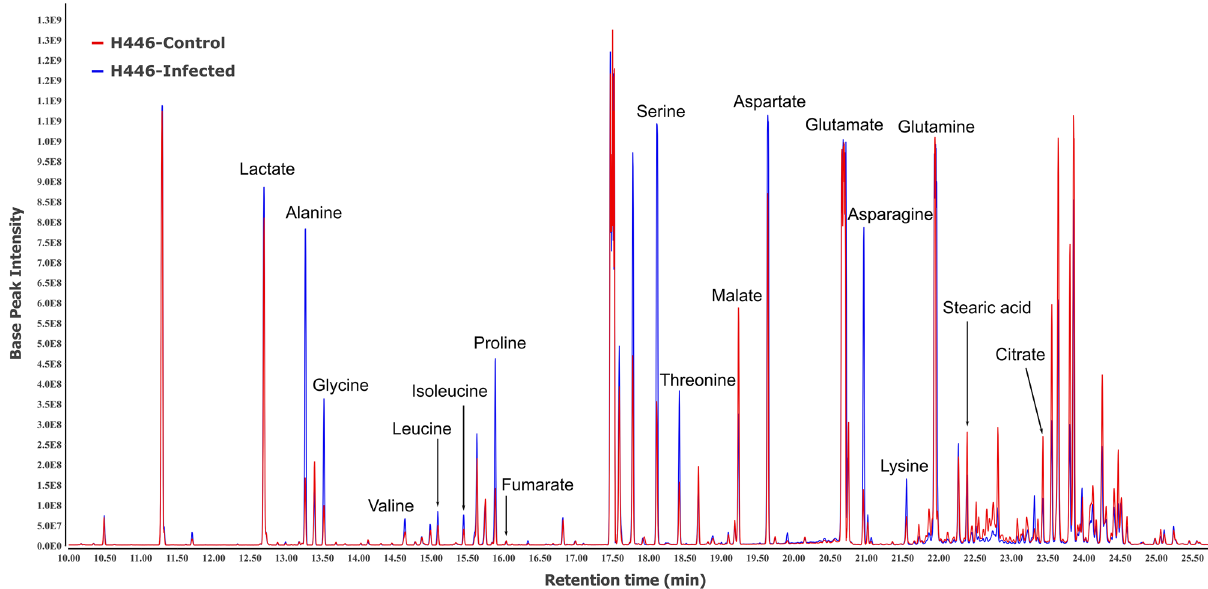
Figure 1. Representative chromatograms of H446 cancer cells: GC–MS profile of H446 control (red) and infected (blue) cells. The chromatographic peaks of the metabolites are labeled in the overlaid chromatograms of H446 control and infected cells. Qualitatively, levels of lactate, alanine, proline, serine, aspartate, asparagine, leucine, and isoleucine are different between control and infected